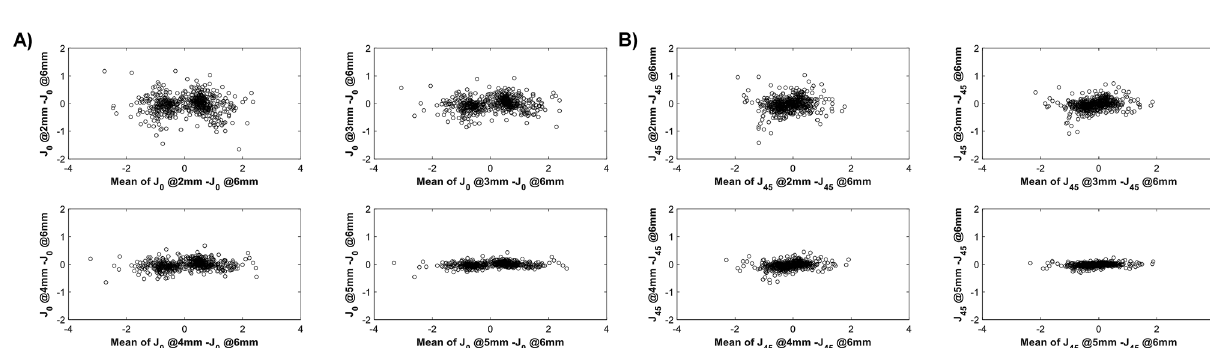
Figure 3. The subtraction of the J 0 ( A ) and J 45 ( B ) components measured at 6 mm and the other concentric areas (from 2 to 5 mm) versus the mean.